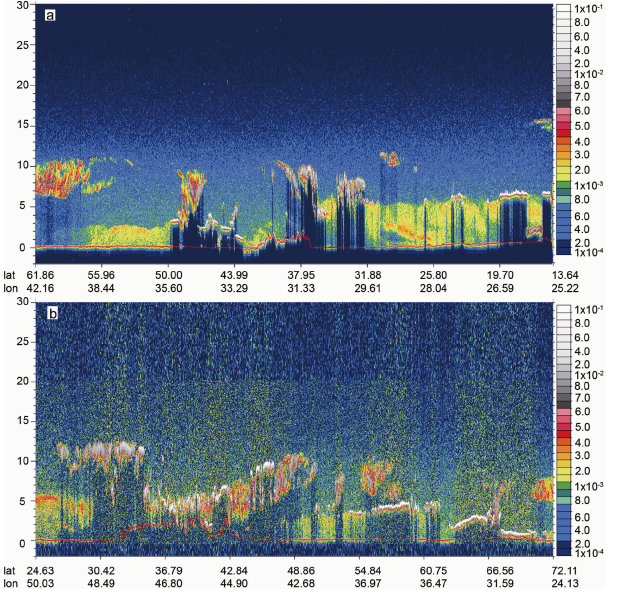
Fig. 4. CALIPSO lidar transects on (a) 00:02-00:16:00UTC 4 May and (b) 10:14–10:27 5 May showing attenuated backscatter coeffi- cient (km − 1 sr − 1 ) profiles at 532nm with 60m vertical and 12km horizontal resolution. The outline of the topography is shown as the solid orange line. Thick clouds appear in white and dust clouds in orange-red.